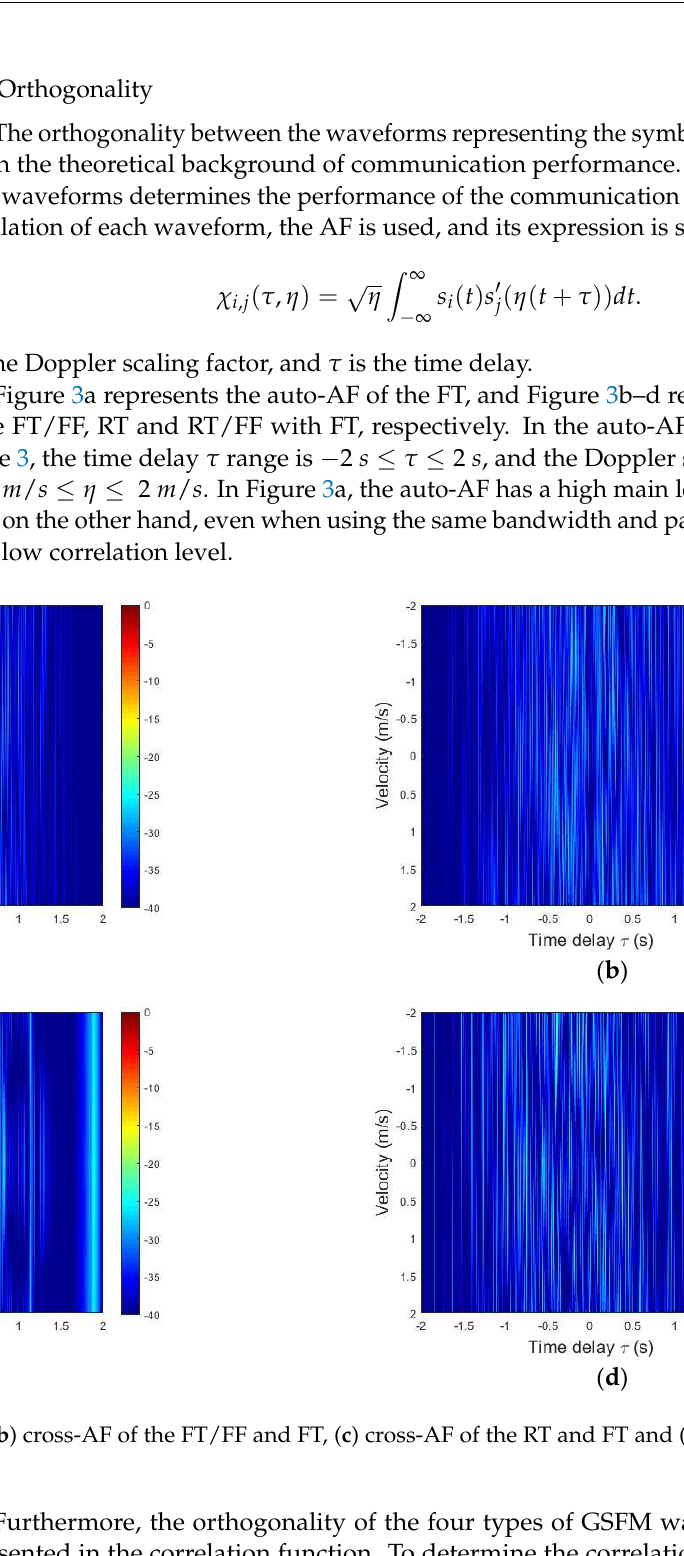
Figure 2. Block diagram of UWA communication by using GSFM waveform.